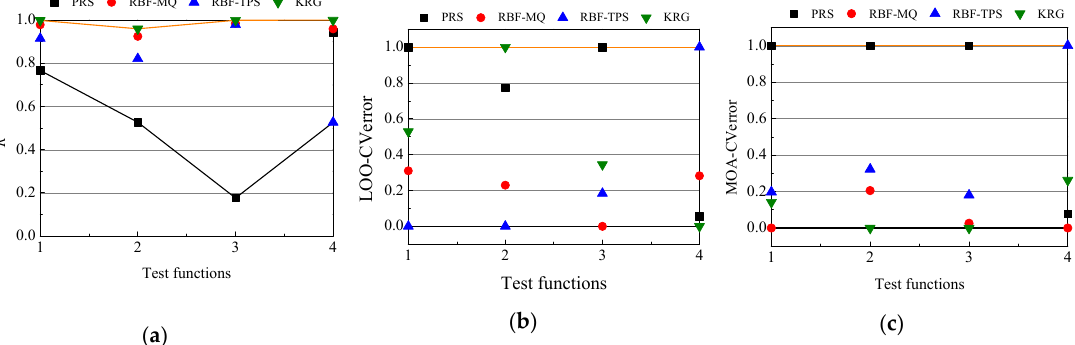
Figure 6. Model ranks by mean of ( a ) R 2 , ( b ) LOO-CVerror and ( c ) MOA-CVerror with 10 n sample points. Table 8. Accurate rate of selecting best models by mean of LOO-CVerror and MOA-CVerror.